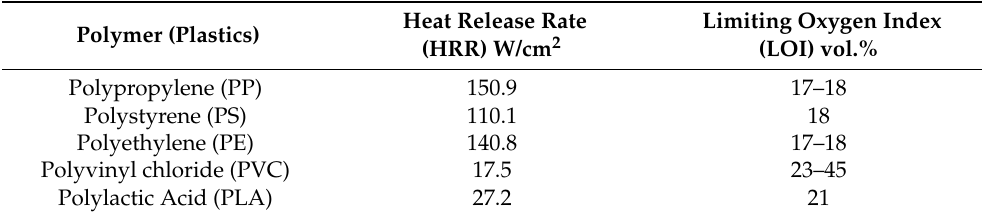
Table 2. List of polymers and their flammability properties